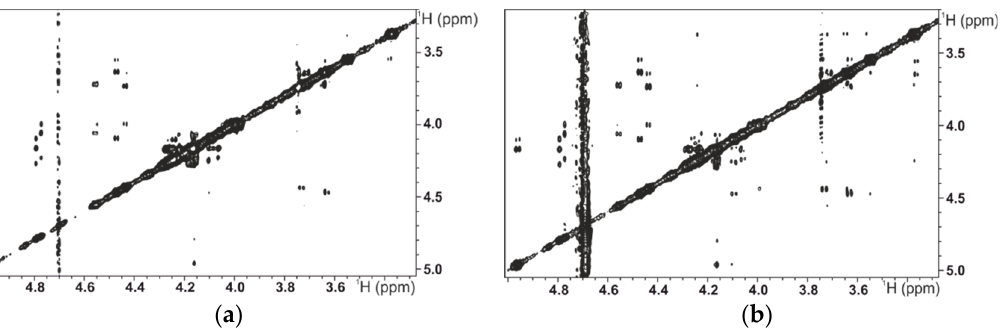
Figure 2. ( a ) NOESY of 1 (1.0 mM) at 200 ms mixing time, at 298 K in 250 μ L PBS buffer (1×), ( b ) in the presence of 20 μ M PTN (transfer NOESY). The vertical scale is the same.